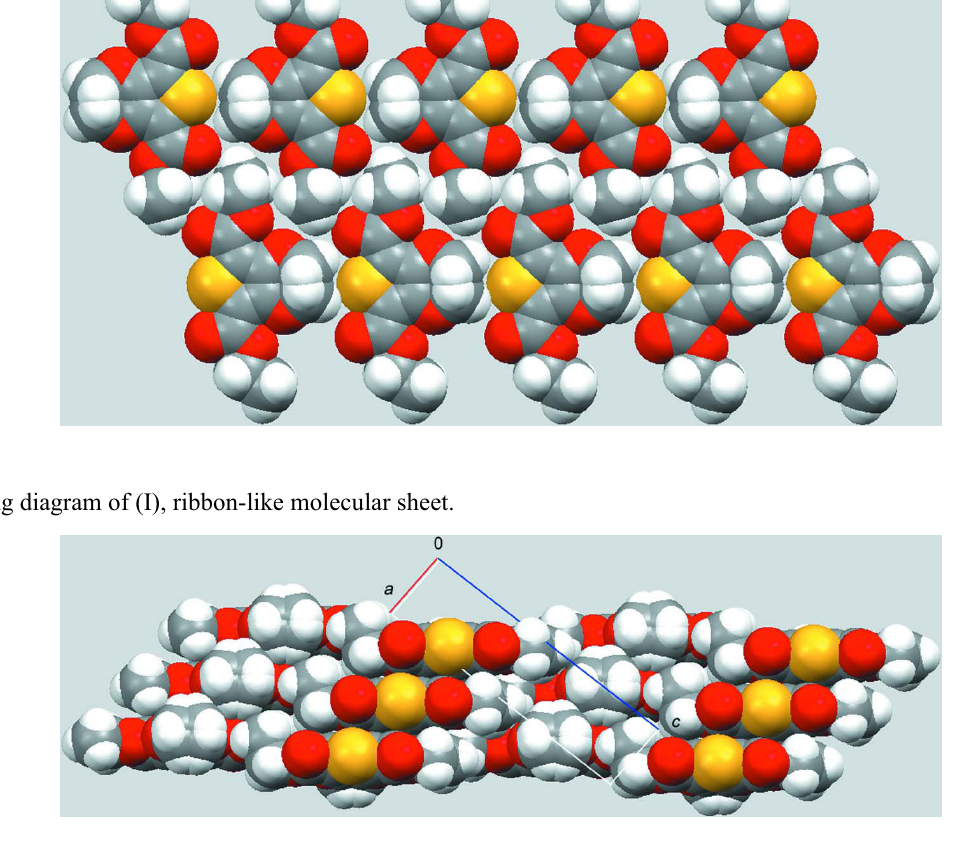
Figure 3 The packing diagram of (I), packing mode of molecular